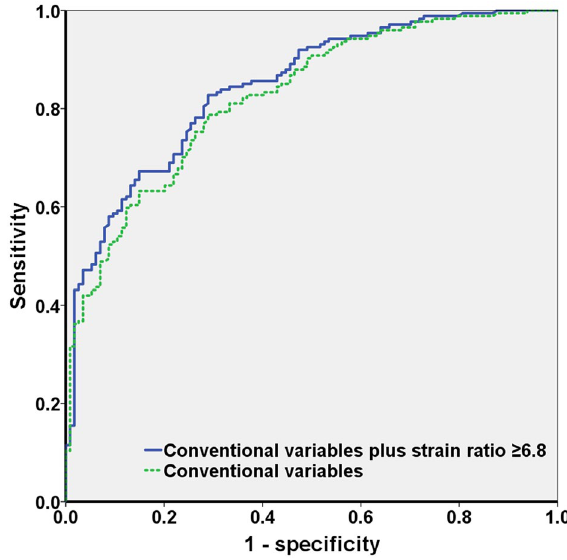
Figure 1. ROC curves of detecting clinically significant prostate cancer lesion using clinical variables and the elastography strain ratio. ROC, receiver operator characteristic.